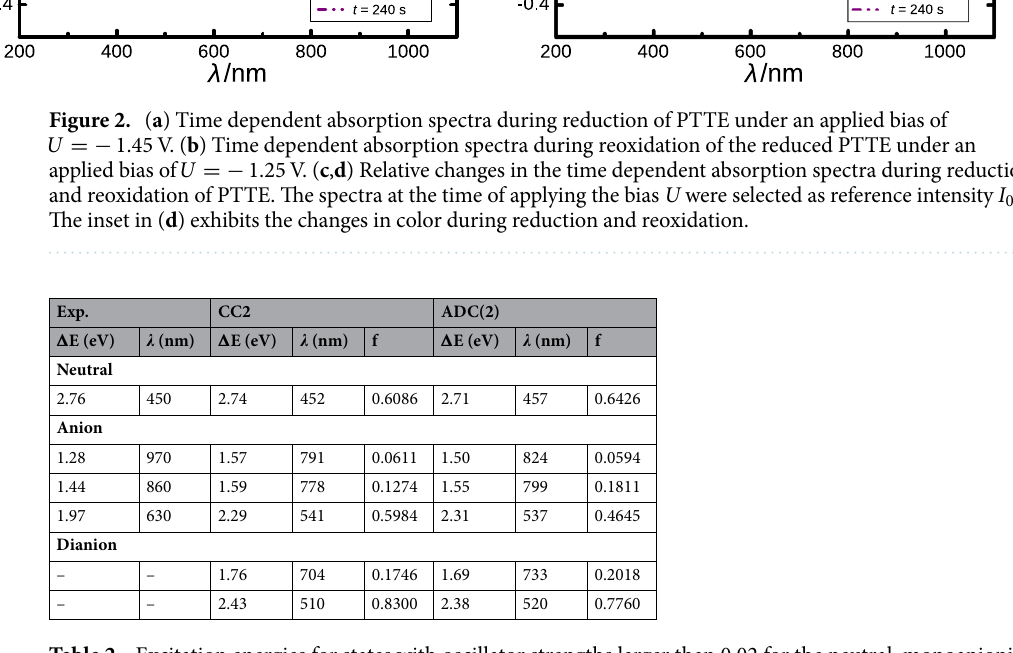
Table 2. Excitation energies for states with oscillator strengths larger than 0.02 for the neutral, monoanionic, and dianionic species of PTTE obtained via RI-CC2 or -ADC(2) with aug-cc-pVDZ basis set based on MP2/6- 311G(d,p) optimized